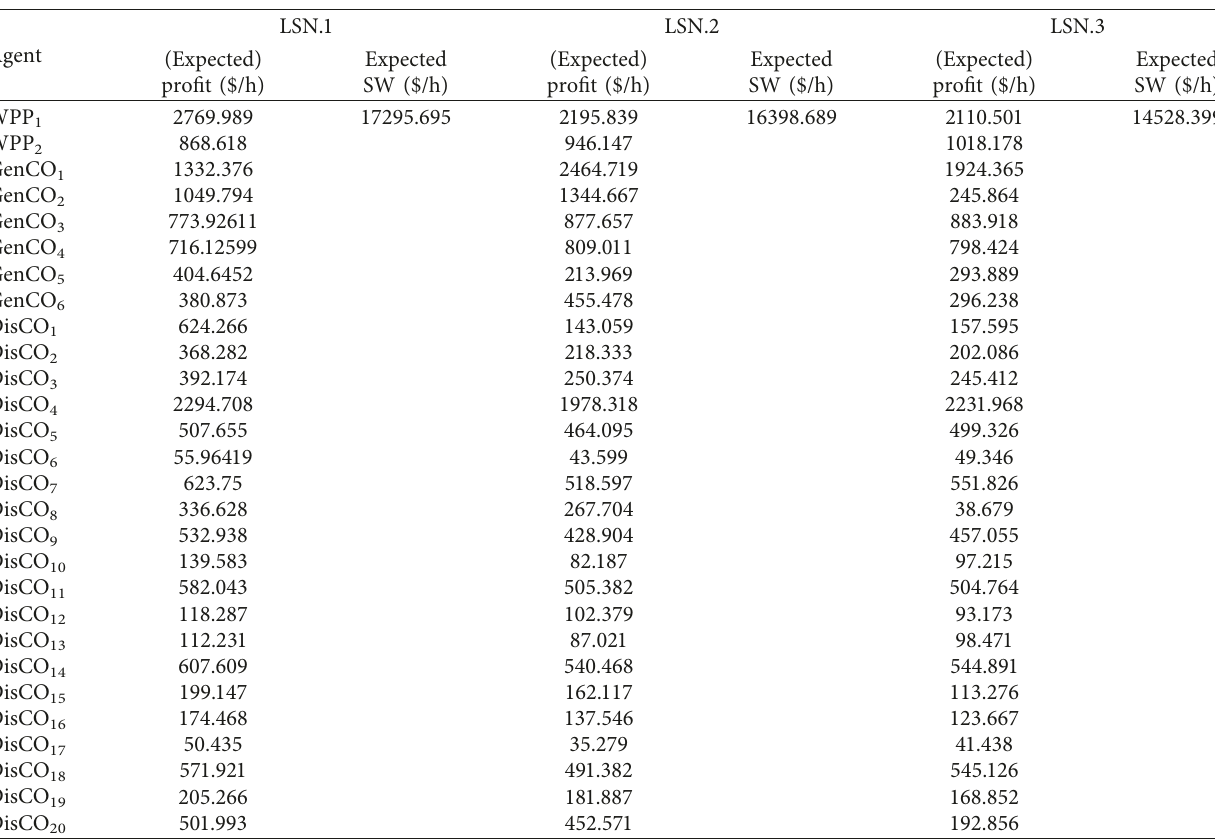
Table 7: (Expected) profit of every agent and expected SW results of 3